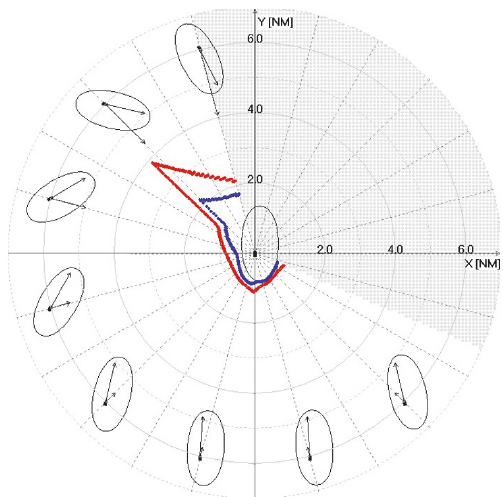
Figure 11: Own ship’s arenas for a target approaching with a true speed of 18 knots (blue line) or 23 knots (red line) in good visibility. Course alterations of up to 90 ∘ tostarboardareconsidered for crossing, coursealterationsto eitherside for being overtaken. No speed reduction is assumed.